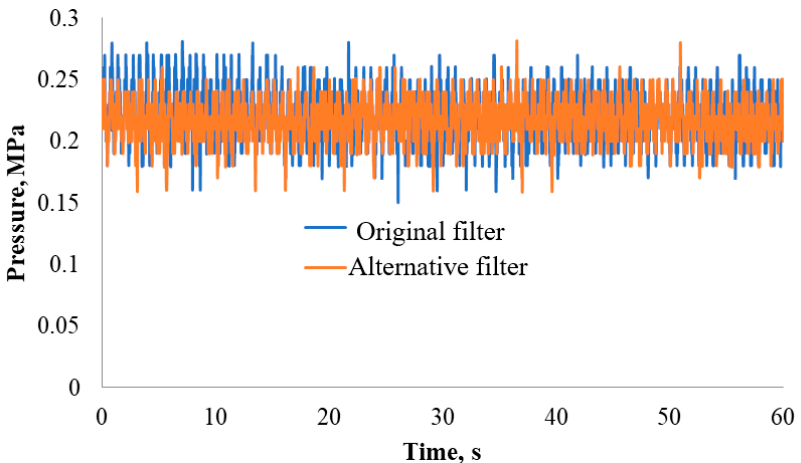
Figure 11. The Plot of measuring the pressure of uncontaminated oil using the tested oil filters at an operating oil temperature of 30 ° C in test circuit B.